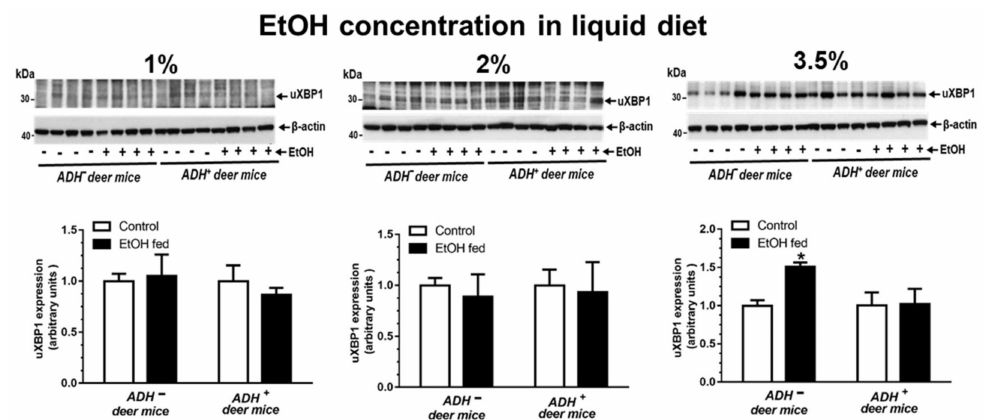
Figure 5. Protein expression ( upper panel ) and relative intensities ( lower panel ) for unspliced-XBP1 (uXBP1) in the livers of ADH − and ADH + deer mice fed 1%, 2% or 3.5% EtOH daily for 2 months. Intensities were normalized to β -actin (loading control). Values are expressed as means ± SEMs ( n = 4). * p value ≤